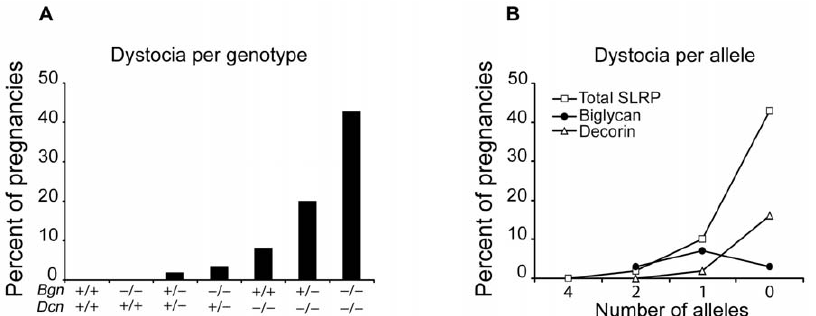
Figure 1. Abnormal rate of dystocia in biglycan/decorin knockout mice. A: Percentage of births displaying dystocia per mouse genotype. Biglycan and decorin are necessary for contractile activity leading to birth in a dose dependent manner. Bgn 2 / 2 Dcn + / + females are not at increased risk of dystocia, while mice lacking one or both decorin alleles are at increased risk of dystocia. P , 0.001. Chi-square test. Bgn + / + Dcn + / + n=13; Bgn 2 / 2 Dcn + / + n=33; Bgn + / + Dcn 2 / 2 n=11; Bgn + / 2 Dcn + / 2 n=14; Bgn + / 2 Dcn 2 / 2 n=20; Bgn 2 / 2 Dcn + / 2 n=30; Bgn 2 / 2 Dcn 2 / 2 n=7. Bgn=biglycan; Dcn=decorin. B: Thepercentage of damsdisplayingdystocia increaseswith decreasingnumber of maternaltotalSLRP( P , 0.001)anddecorin ( P , 0.001) alleles, but is independent of biglycan alleles ( P =0.348). Chi-square test. 4 SLRP alleles n=13; 2 SLRP alleles n=58; 1 SLRP allele n=50; 0 SLRP alleles n=7. SLRP=small leucine rich proteoglycan.